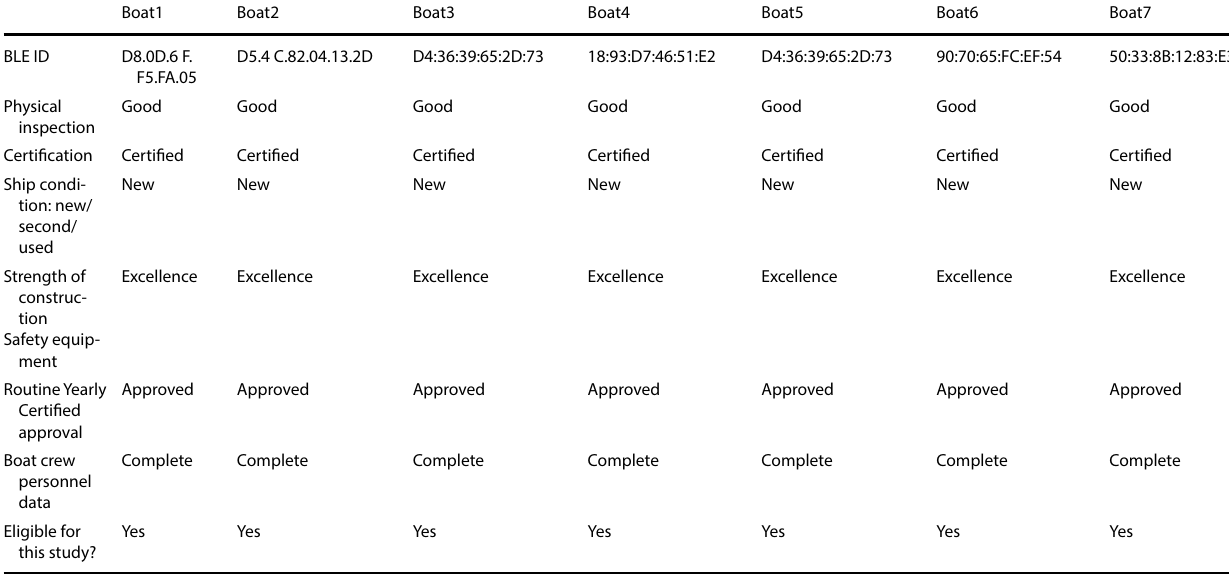
Table 1 eligibility requirement for this study Modified by author from the Ministerial decree no. PM 39 Year 2017 related to the Ship’s Registration. The boat of less than GT.7 need not to be reg-